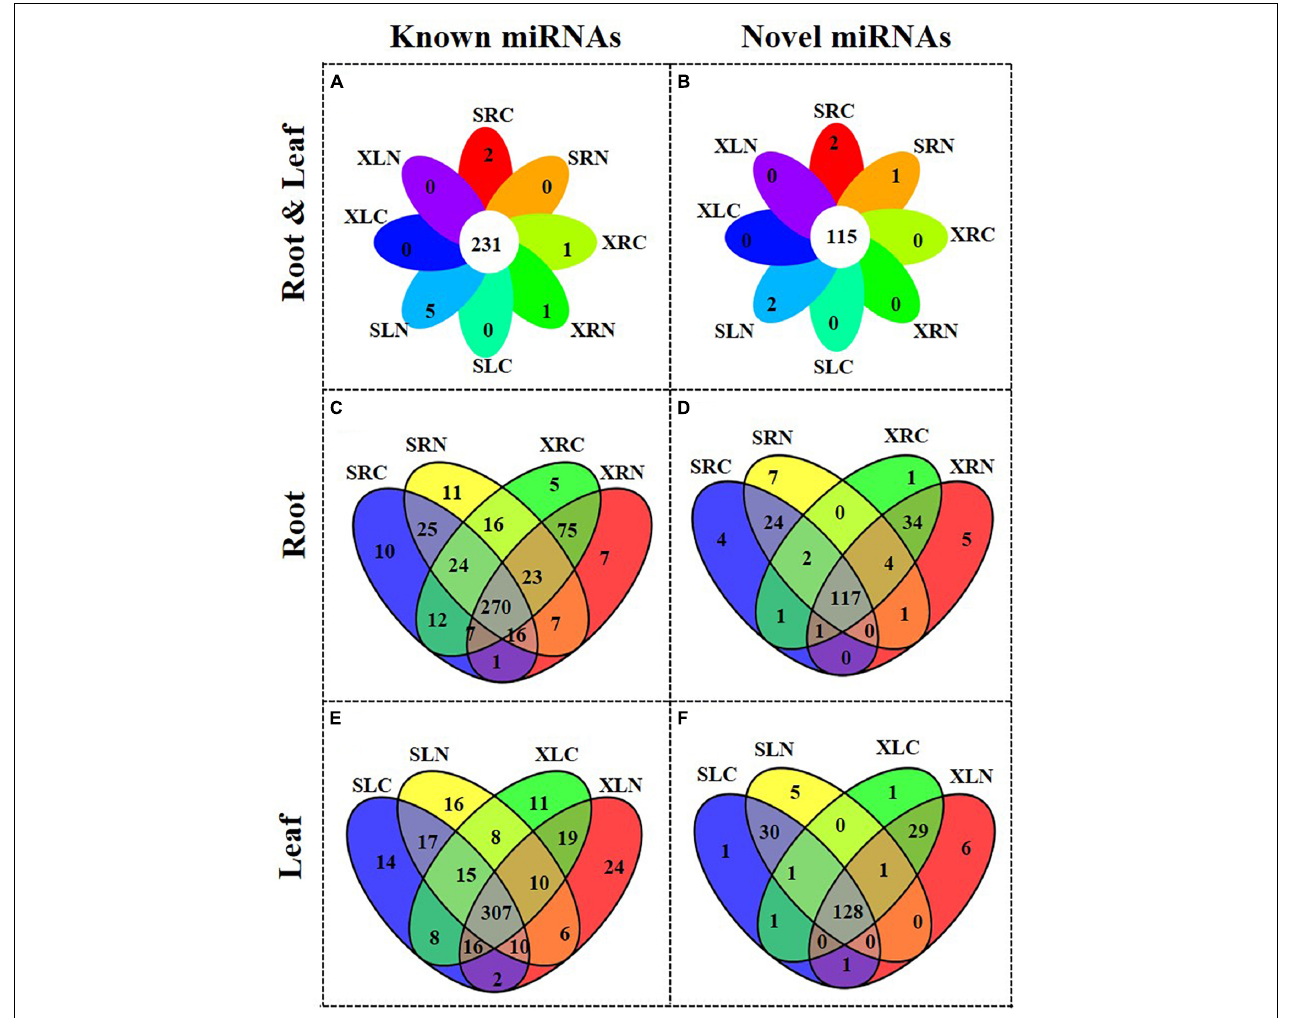
FIGURE 3 | Distribution of known and novel miRNAs in roots and leaves of two sweetpotato cultivars “Xushu 22” and “Xushu 32.” (A) Known miRNAs in roots and leaves; (B) Novel miRNAs in roots and leaves; (C) Known miRNAs in roots; (D) Novel miRNAs in roots; (E) Known miRNAs in leaves; (F) Novel miRNAs in leaves.